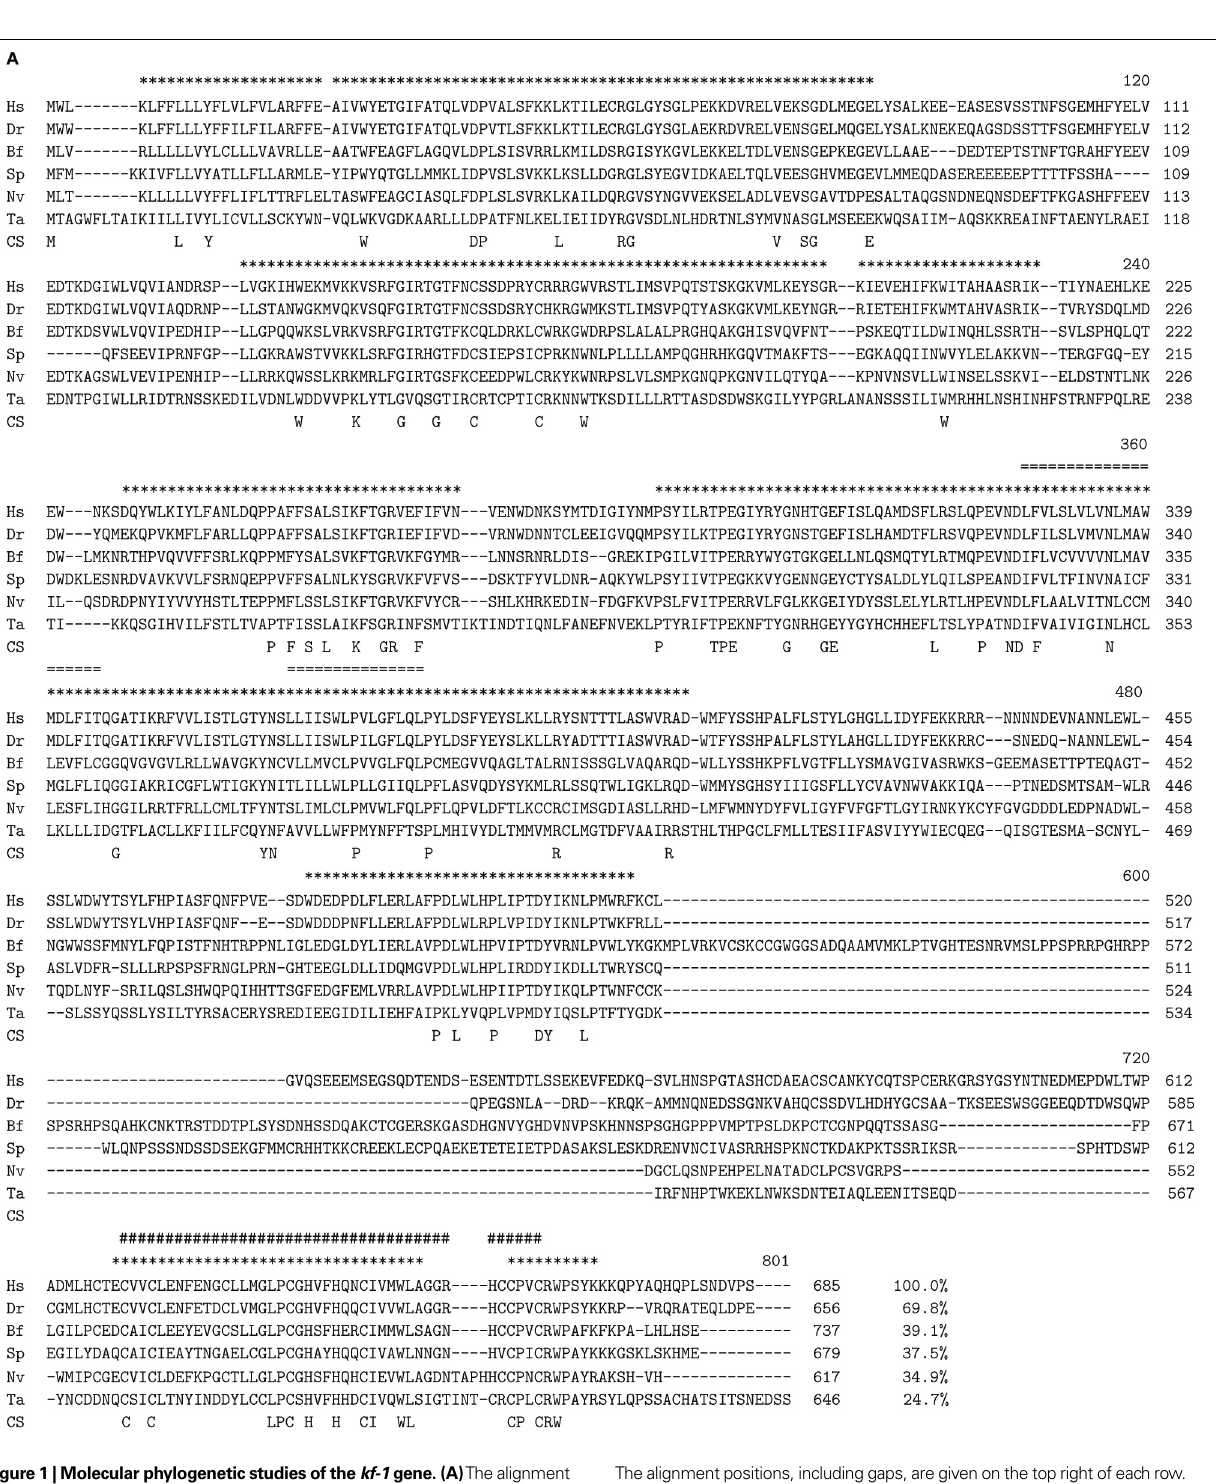
The alignment positions, including gaps, are given on the top right of each row. Hs, Dr, Bf, Sp, Nv, and Ta denote Homo sapiens , Danio rerio , Blanchistoma fl oridae , Strongylocentrotus purpuratus , Nematostella vectensis and Trichoplax adhaerens , respectively. The gene identifi cation (GI) numbers are 1945615, 52219054, 210102052, 115660659, 156406687, and 196009364 in the respective species. Blast Expect values (blastp with BLOSUM62 for Matrix) of Dr, Bf, Sp, Nv, and Ta against Hs are E < 10 − 130 , E = 2 × 10 − 130 , E = 3 × 10 − 117 , E = 3 × 10 − 104 , and E = 3 × 10 − 57 , respectively. CS denotes consensus amino acid.